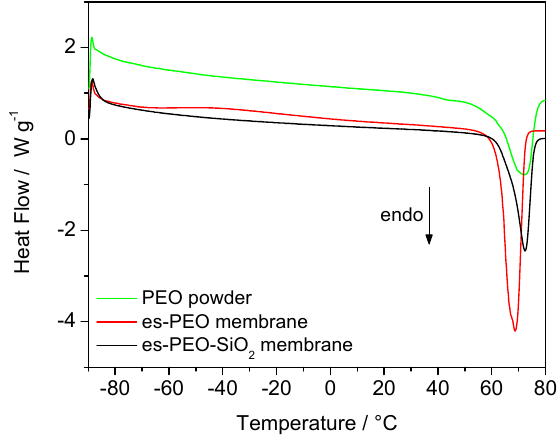
Figure 3. Heating scan of the DSC curves recorded for the two electrospun pristine membranes and for pure PEO powder. Table 1. Enthalpy change and temperature related to PEO melting (values derived from DSC response in Figure 3).